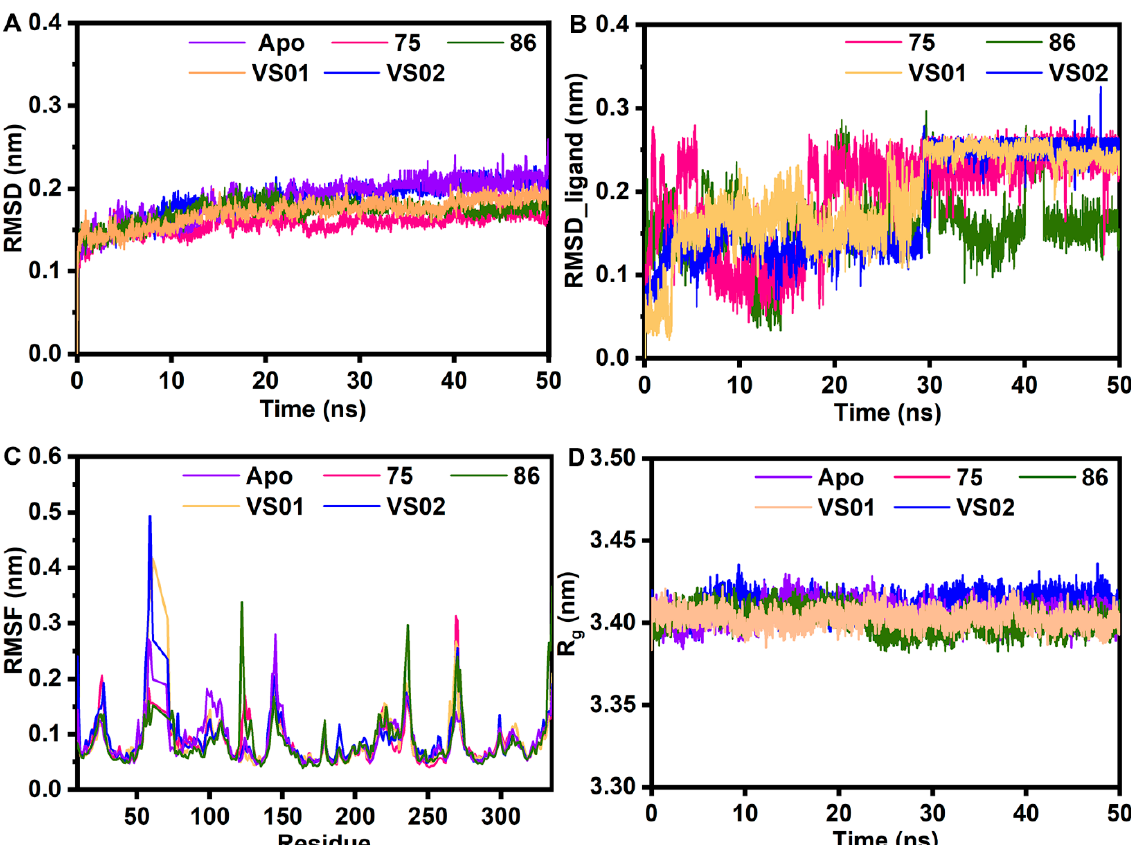
Figure 7. The MD results of the five complex systems: apo FBPase (purple), FBPase- 75 (magenta), FBPase- 86 (green), FBPase- VS01 (orange), and FBPase- VS02 (blue). ( A ) The RMSD of the backbone atoms of the proteins. ( B ) The RMSD of the ligands ( 75 , 86 , VS01 , VS02 ). ( C ) The RMSF of the Chain A residues. ( D ) The R g of the proteins.